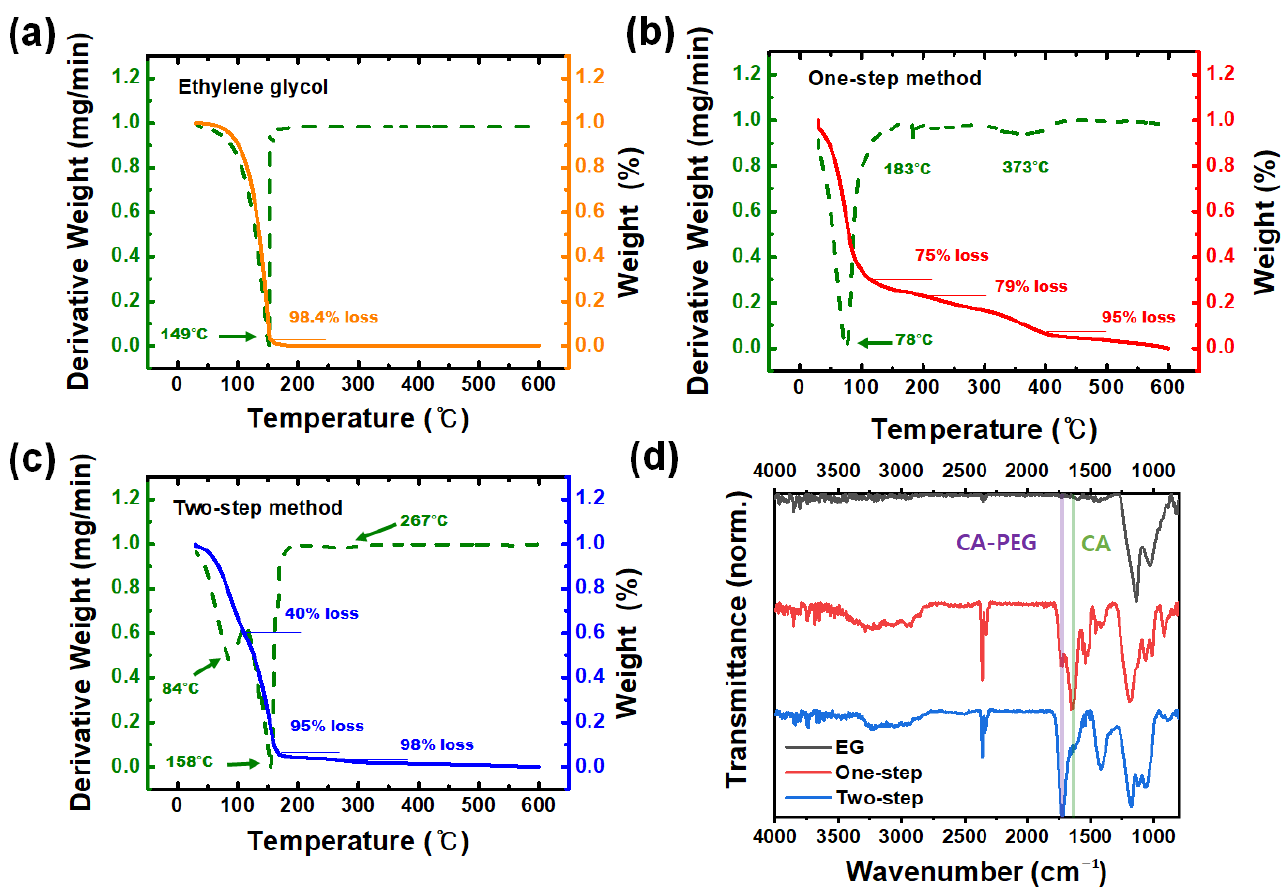
Figure 2. Thermogravimetric analyzer (TGA) data for the solutions of ( a ) ethylene glycol and ( b ) the one-step and ( c ) two-step spin-coating precursors to form the BeO layers; ( d ) Fourier transform infrared (FTIR) analysis outcomes for each of the solutions.